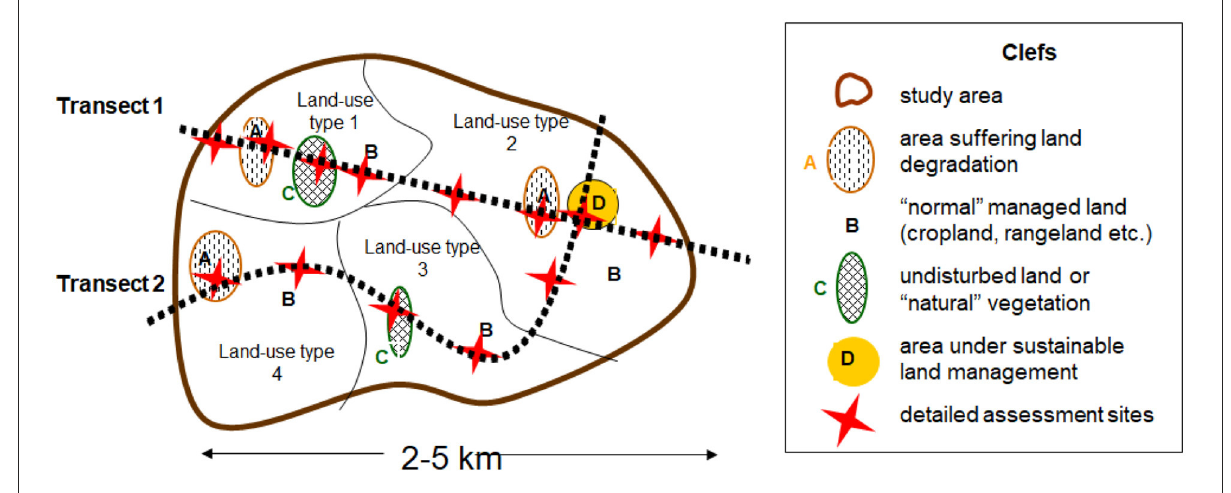
FIGURE5 Detailed study sites along transect lines across land use